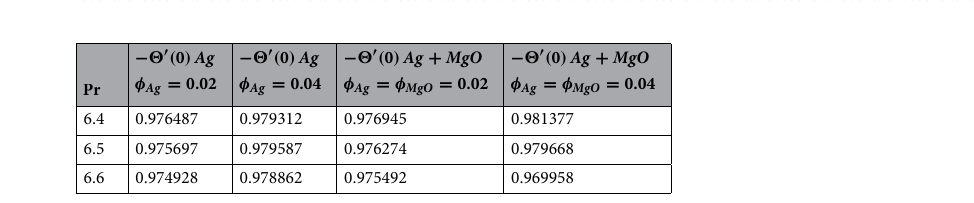
Table 2. Numerical outputs of Nusselt number − � ′ ( 0 ) at the surface of disc.